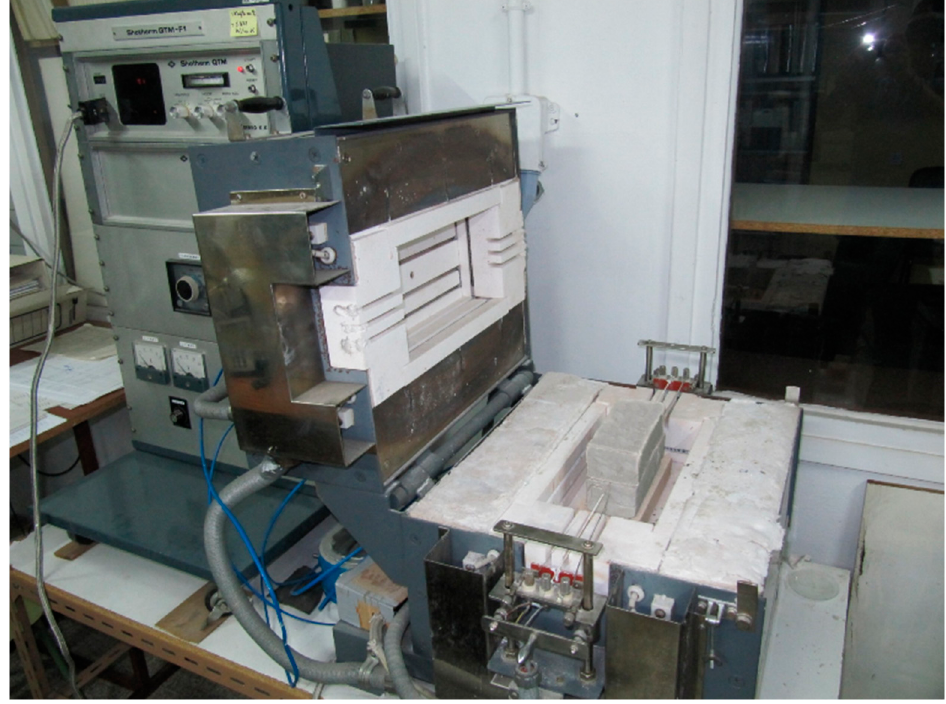
Figure 6. Shotherm QTM-F1 thermal conductivity meter.